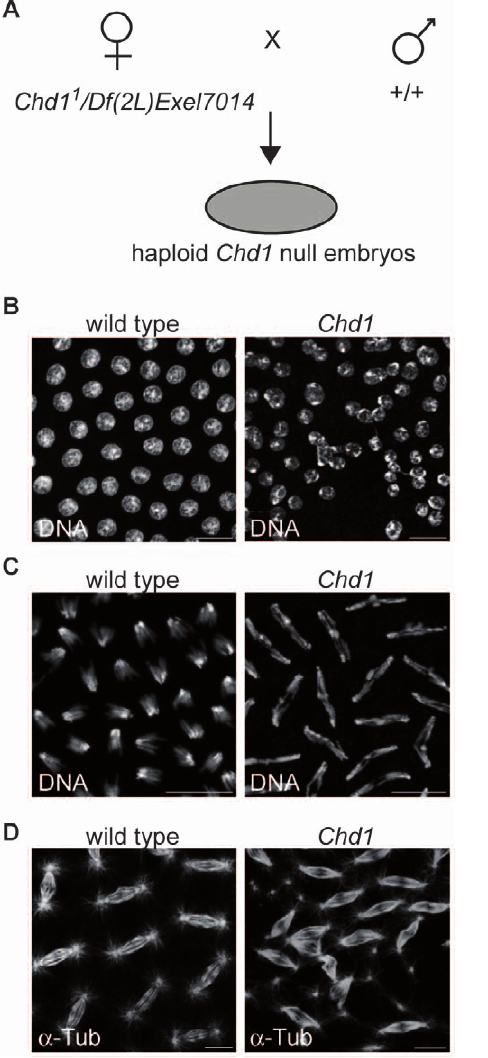
Figure 4. A fraction of DrosophilaChd1 null embryos displays aberrant nuclear morphology and mitotic defects. A) Schematic representation of the generation of Chd1 null embryos. B) The Chd1 mutation occasionally leads to the appearance of irregularly sized and arranged nuclei. C) Mitotic defects, such as lagging chromosomes and disorganized spindles (D), were observed in 15.6% of mutant embryos (n=295) in contrast to only 1% (n=209) of wild-type embryos. DNA was stained with DAPI (B, C), mitotic spindles were visualized by staining with an antibody against a -tubulin (D). Scale bars =10 m m. doi:10.1371/journal.pone.0010120.g004 Chd1 mutant fly embryos and the intact localization of the kinetochore components CENP-C and BubRI in Chd1 null embryos, that strongly argue against a critical function for CHD1 in this process. These findings stand in contrast to those from previous studies of CHD1 in S. pombe , chicken and human cells [12,13]. In hrp1 D mutant strains in fission yeast, it was shown by ChIP that CenH3 Cnp1 levels are substantially reduced, whereas H3 levels are increased relative to wild-type yeast over the central core region of the centromeres. Moreover, Hrp1 was found to colocalize with centromeric regions during G1/S phase [12].